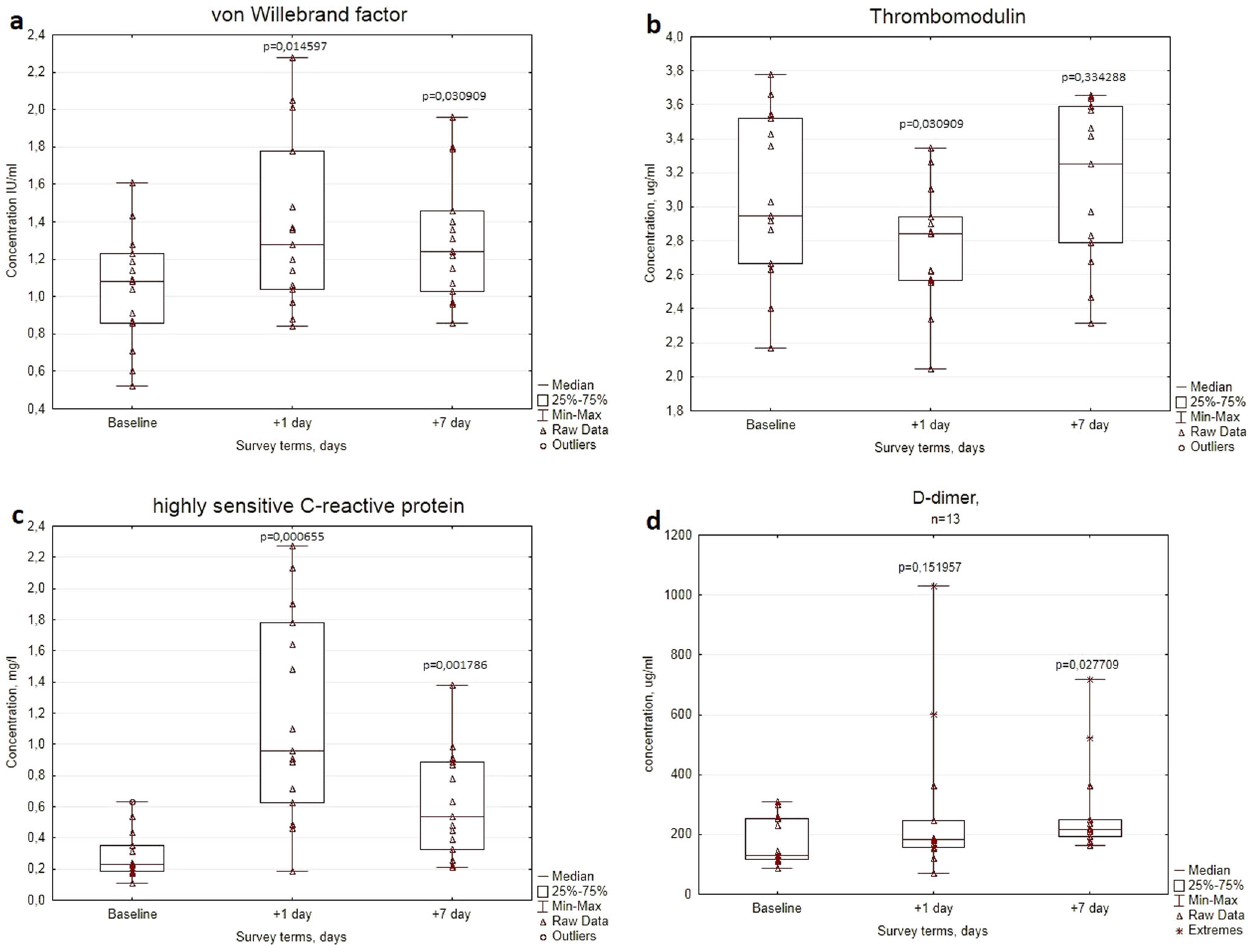
Fig. 1 The concentrations of the blood plasma parameters of cosmonauts before the mission (Baseline) and after space fl ight completion (Days + 1 and + 7). a von Willebrand factor, b thrombomodulin, c highly sensitive C-reactive protein, and d D-dimer. The center lines represent the median, the bounds of boxes represent the 25th percentile and 75th percentile (Q1 and Q2 correspondingly), the bonds of whiskers represent the minimum and the maximum values, the triangles within the diagrams are the raw data for particular volunteers, p values were obtained using the Wilcoxon ’ s